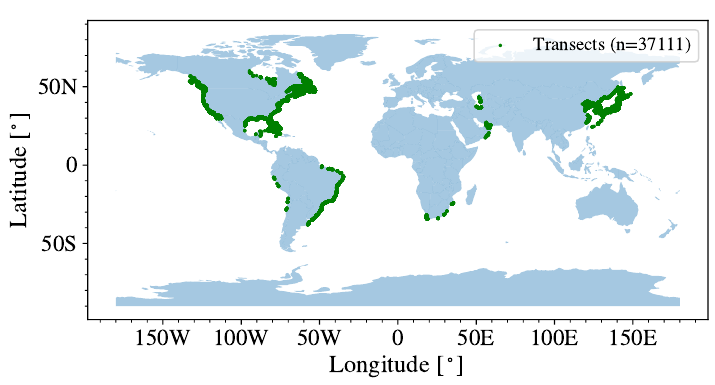
Figure 2. Transect sites with SDS time-series included in the forecast evaluation